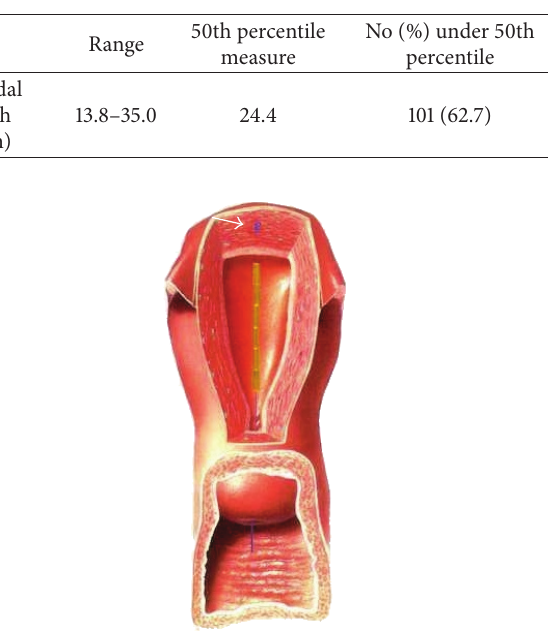
Table 1: Fundal transverse diameter (mm) in 165 Finnish nulli- parous women [6].